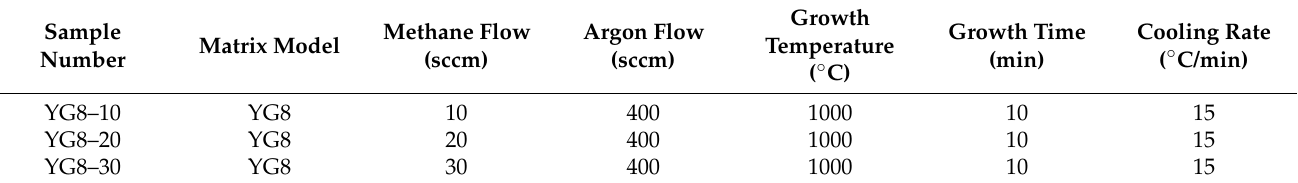
Table 3. The process parameters based on methane flow.